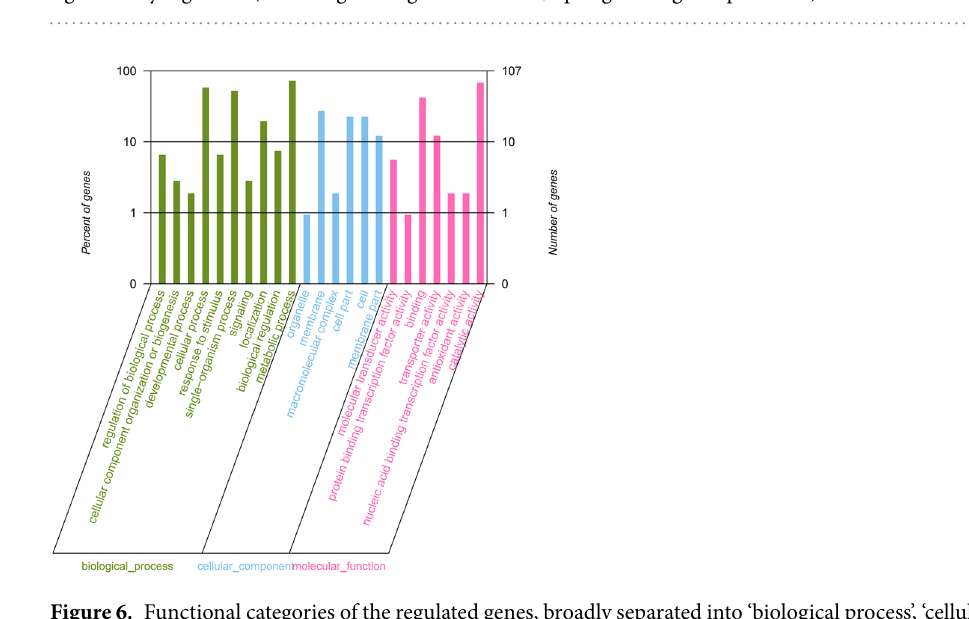
Figure 5. Volcano plots of the overall scatter of gene transcription of M. olearia Th120 (with or without indole treatment). P value < 0.05 and |log2 (foldchange)| > 1 were selected as the criteria to filter genes that were significantly regulated (down-regulated genes blue dots, up-regulated genes pink dots).